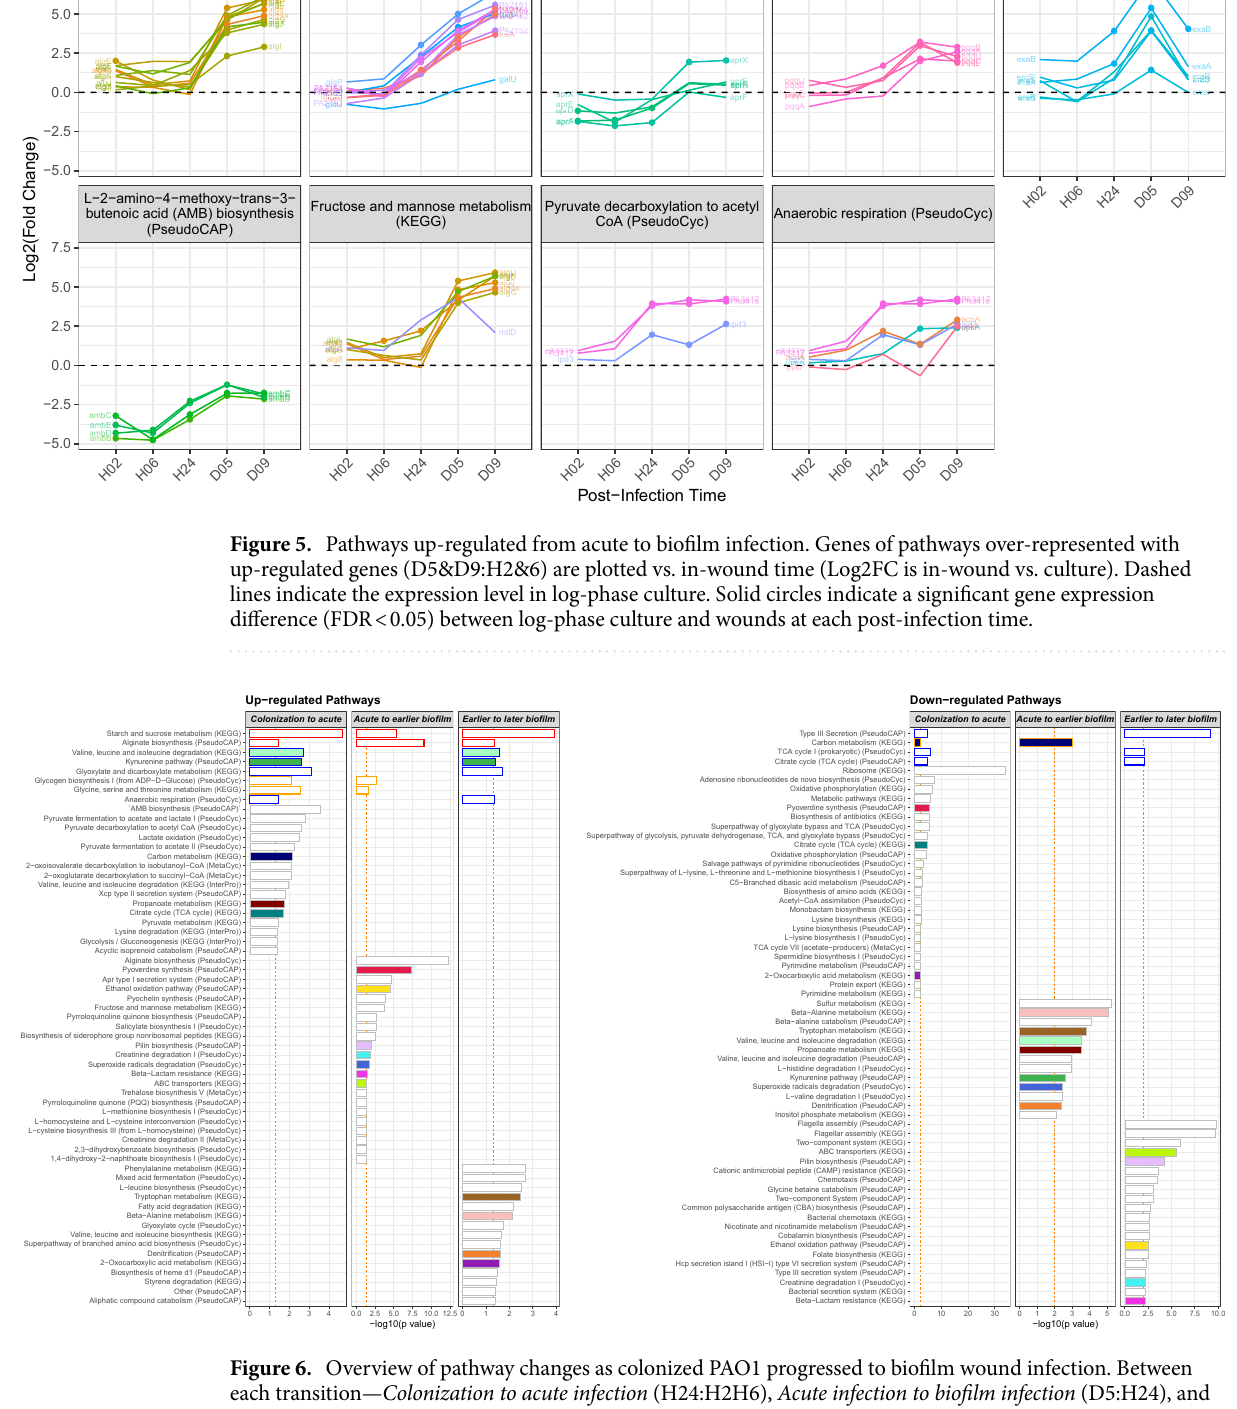
Figure 6. Overview of pathway changes as colonized PAO1 progressed to biofilm wound infection. Between each transition— Colonization to acute infection (H24:H2H6), Acute infection to biofilm infection (D5:H24), and Earlier to later biofilm infection (D9:D5)—the pathways with over-represented up- or down-regulated genes are graphed vs. the p value of the overrepresentation of the genes into the pathways; the −log10 of the p value is graphed so more significant values are larger. Vertical dashed orange lines indicate p values < 0.05 or 0.01 for the up-and down-regulated pathways, respectively (so a similar number of pathways could be graphed since more pathways were enriched with down-regulated genes). Red-outlined bars indicate pathways changed in all comparisons. Blue-outlined bars indicate pathways changed between Colonization to acute infection and Earlier to later biofilm . Orange-outlined bars indicate pathways changed between Colonization to acute infection and Acute to earlier biofilm infection. Colored bars indicate pathways changed between any two